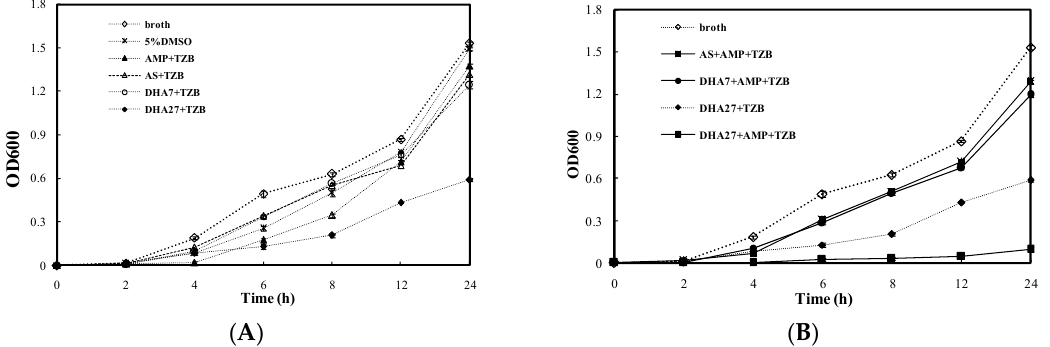
Figure 4. Dynamic growth curves of E. coli ATCC 35218. E. coli ATCC 35218 from the exponential phase was diluted with LB broth to 1.0 × 10 6 cfu/mL. Then, 64 mg/L artesunate (AS), DHA7 and DHA27 alone, and in combination with ampicillin (AMP)/tazobactam (TZB) were added to bacterial suspensions. Broth and 5% DMSO were negative control and solvent control, respectively. The bacterial growth was determined by measuring OD 600 at regular intervals. ( A ) The effect of drugs alone on growth of E. coli ATCC 35218; ( B ) The effect of drugs in combination of AMP on growth of E. coli ATCC 35218.